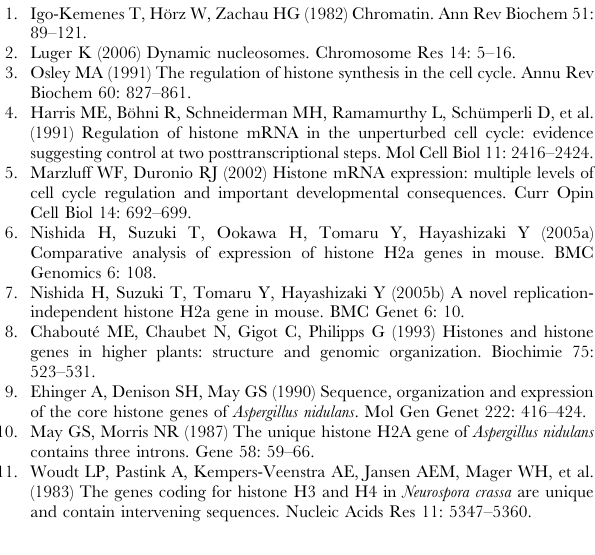
Table S5 Introns with sequence similarity. Yellow indicates the intron pair with different insertion sites in the same histone gene. Orange indicates the intron pair of different histone genes. The other indicates the intron pair with the same insertion site in the same histone gene. Table S6 Results ( E -value , 0.02) of the Fungi Genome BLAST in the Fungal Genomes Central on the NCBI web site for each intron used in this study. The hit sequence ID with the score (bits) and E -value are